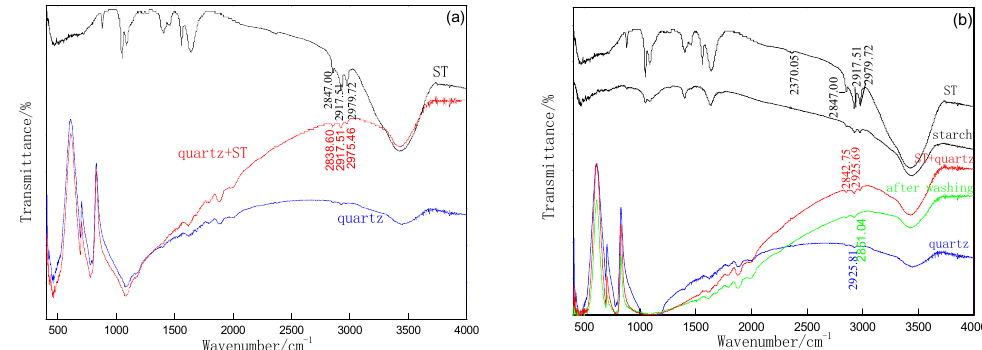
Figure 15. Infrared spectra of quartz before and after the action of ( a ) toluenesulfonamide(ST) and ( b ) starch and toluenesulfonamide(ST).